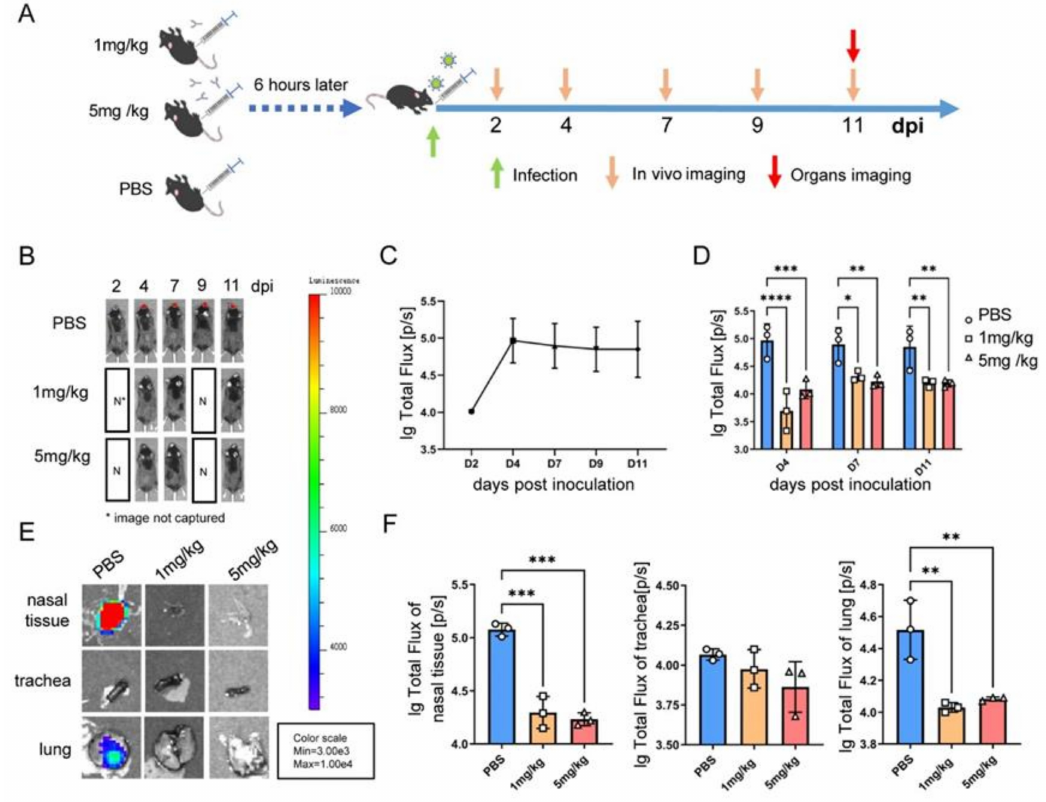
Figure 5. Establishment of a BLI model and evaluation of the in vivo antiviral activity of humanized monoclonal antibody. ( A ) Experimental schedule for the establishment and evaluation of BLI model based on Rag2 − / − mice. Two dosage of antibody groups (1 and 5 mg/kg) were administered intraperitoneally 6 h before the hRSV-Fluc challenge, the control group was administered with PBS. ( B ) All Rag2 − / − mice were intranasally infected with hRSV-Fluc (1 × 10 6.5 TCID 50 ), and the Bioluminescent images of the live micewere measured using the IVIS-Lumina II imaging system on 2, 4, 7, 9, and 11 dpi. Relative bioluminescence intensity was shown in pseudocolor, with red representing the strongest and blue representing the weakest photon fluxes. The bioluminescence intensity of control group mice at 5 time points ( C ) and comparison between 3 groups at 3 time points ( D ) after infection are shown as means ± deviation. The statistical significance was evaluated using two-way ANOVA. * p < 0. 05, ** p < 0. 01, *** p < 0.001, **** p < 0.0001 ( E , F ) Organs were examined for Fluc expression using BLI on 11 dpi. The statistical significance was evaluated using one-way ANOVA. ** p < 0. 01, *** p <